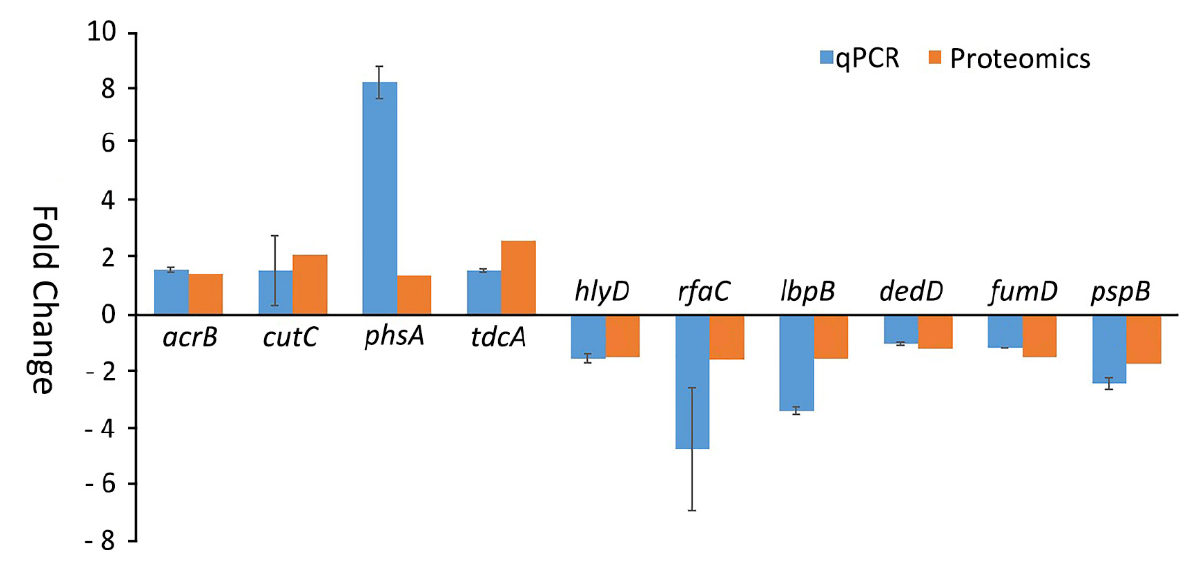
Figure 6. Validation of proteomic (HPLC-iTRAQ) data by qRT-PCR analysis. The proteomic data of selected proteins (AcrB, CutC, PhsA, TdcA, HlyD, RfaC, IbpB, DedD, FumD and PspB) were evaluated by comparing their abundances with the expression levels of their gene under the same conditions.